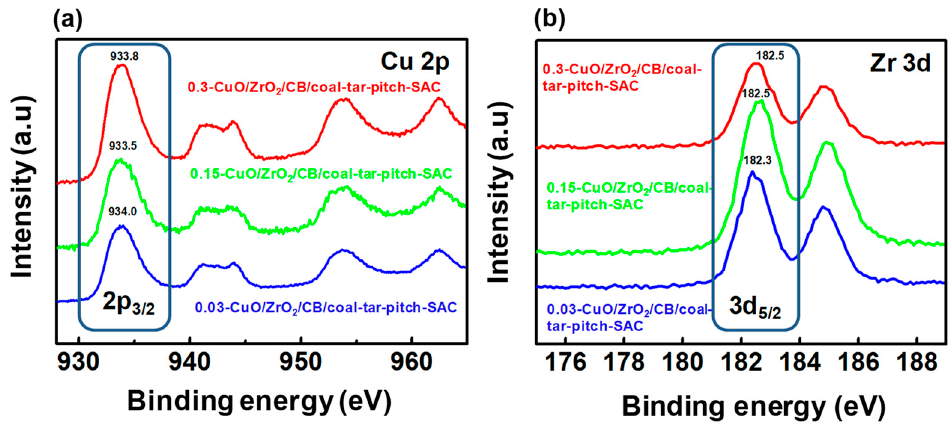
Figure 5. XPS results of Cu 2p 3/2 ( a ) and Zr 3d 5/2 ( b ) in CuO/ZrO 2 /CB/coal-tar-pitch-SAC composite materials.